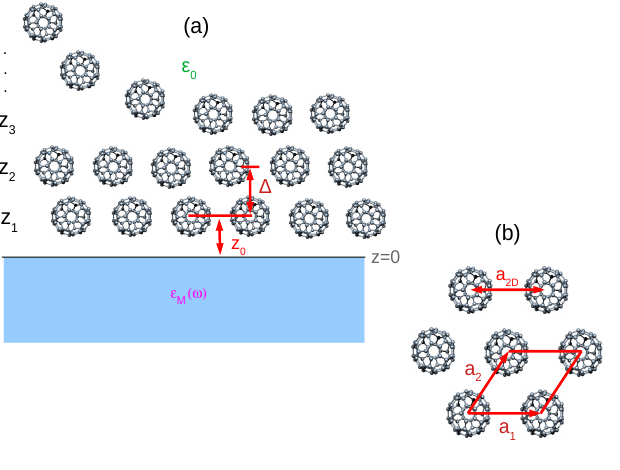
Figure 1. ( a ) C 60 molecules upon deposition on the surface self-assemble in a regular FCC structure forming a (111) surface. The C 60 layers, occupying z > 0 half-space, are immersed in a dielectric medium described by a dielectric constant (cid:101) 0 . The dielectric response of the substrate, occupying z < 0 half-space, is approximated by a local macroscopic dielectric function (cid:101) M ( ω ) . The FCC lattice constant is a 3D = 14 Å so that the separation between the layers is ∆ = a 3D / crystal plane forms a 2D-hexagonal Bravais lattice with lattice constant a 2D = a 3D /